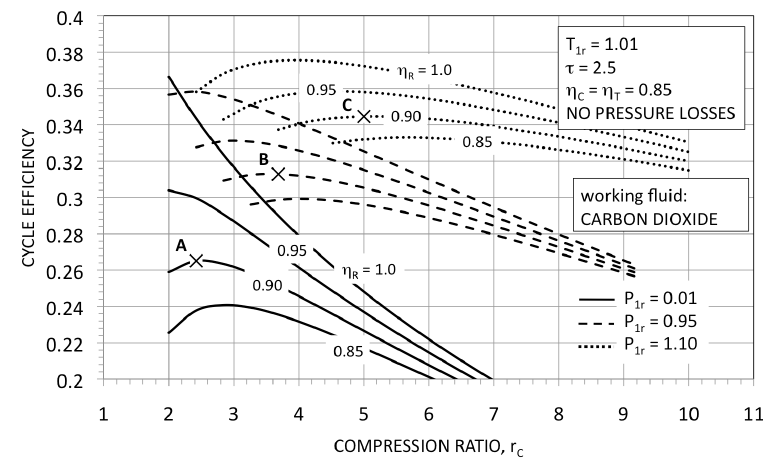
Figure 2. Effects on the thermodynamic efficiency of the minimum reduced pressure P 1, r fixing the reduced minimum temperature T 1, r and the temperature ratio τ .